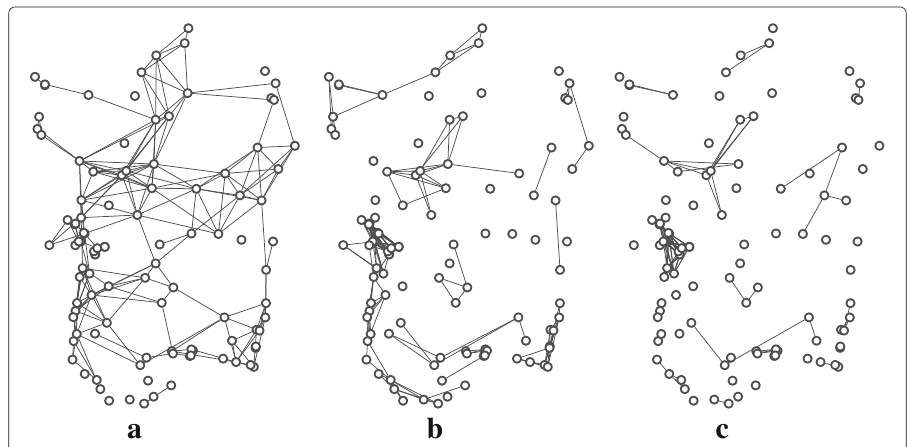
a b c Fig. 2 Similarity-based graph models of Sardinian Natura 2000 sites, with a 0.5 similarity score threshold and a 30 Km distance threshold. a Based on CORINE land use codes. b Based on Natura 2000 habitat codes. c Based on species sets